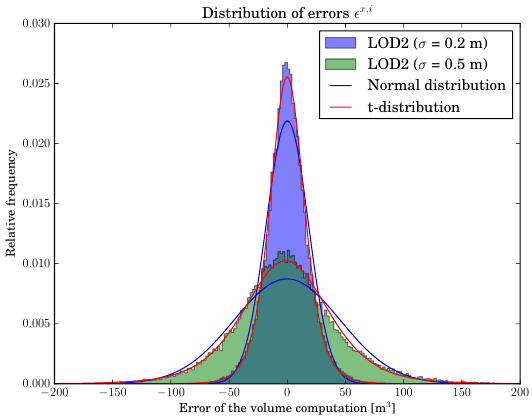
Figure 8: Distribution of volume errors in the accuracy classes σ = 0.2 and 0.7 for LOD2, with the attempts of fitting two prob- ability distribution functions.